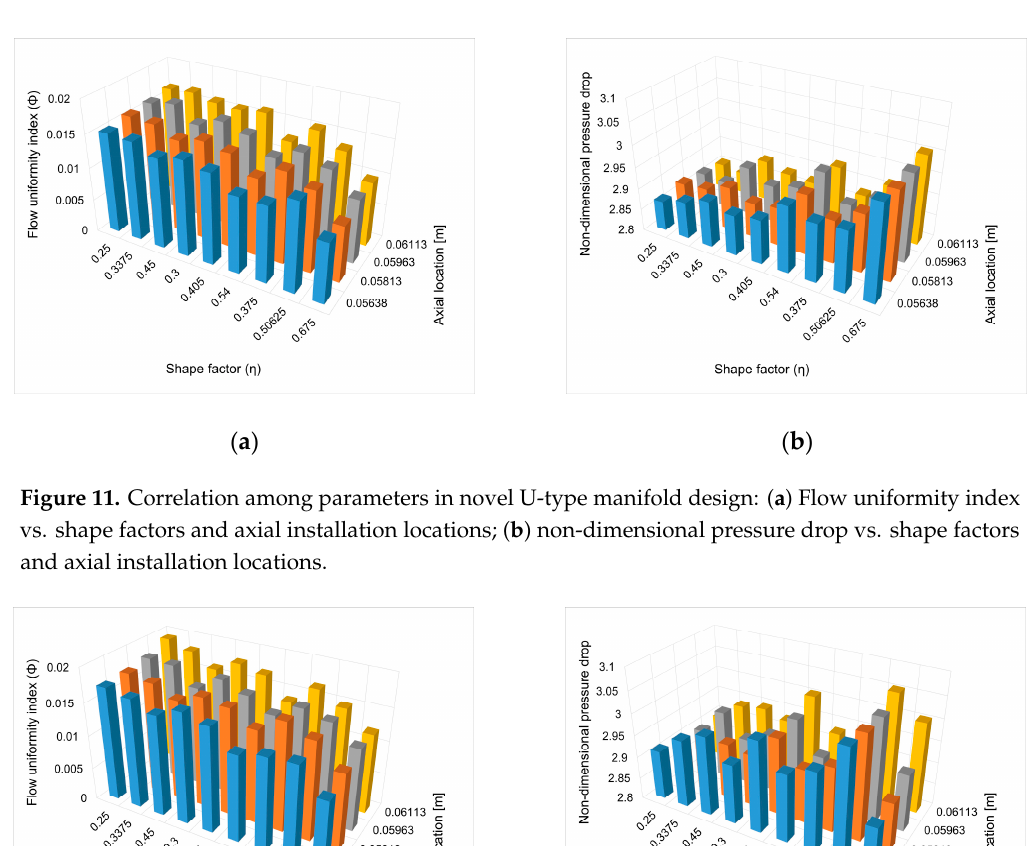
Figure 12. Correlation among parameters in novel Z-type manifold design: ( a ) Flow uniformity index vs. shape factors and axial installation locations; ( b ) non-dimensional pressure drop vs. shape factors and axial installation locations.